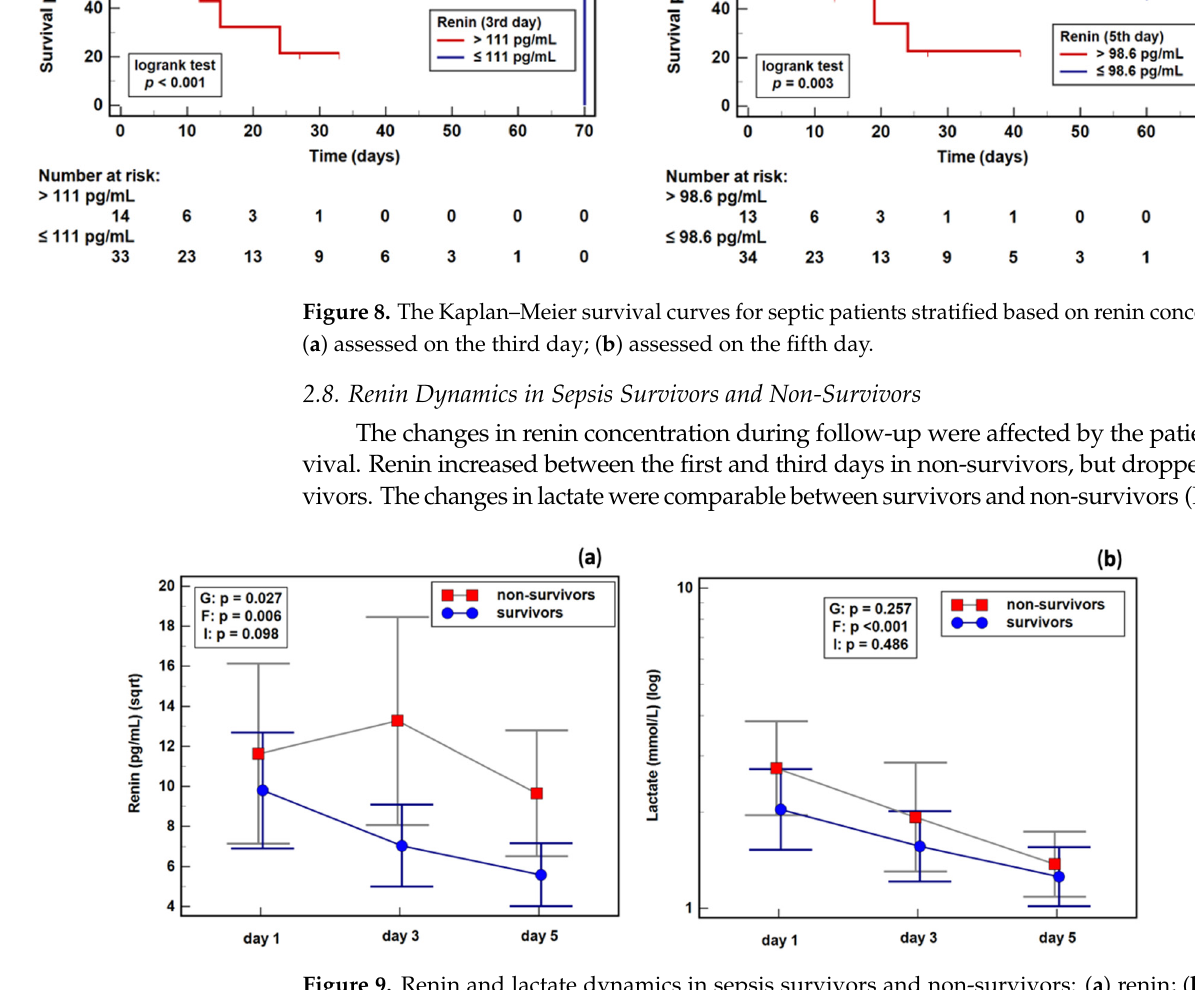
Figure 9. Renin and lactate dynamics in sepsis survivors and non-survivors: ( a ) renin; ( b ) lactate. Notes: Data were analyzed using repeated measures ANOVAs on data transformed into squared roots (sqrt; renin) or logarithms (log; lactate) and are presented as means (red squares and blue dots) with 95% confidence intervals (gray and blue whiskers). G, the group effect (survivors vs. non-survivors); F, the factor effect (day of testing); I, group and factor interaction.